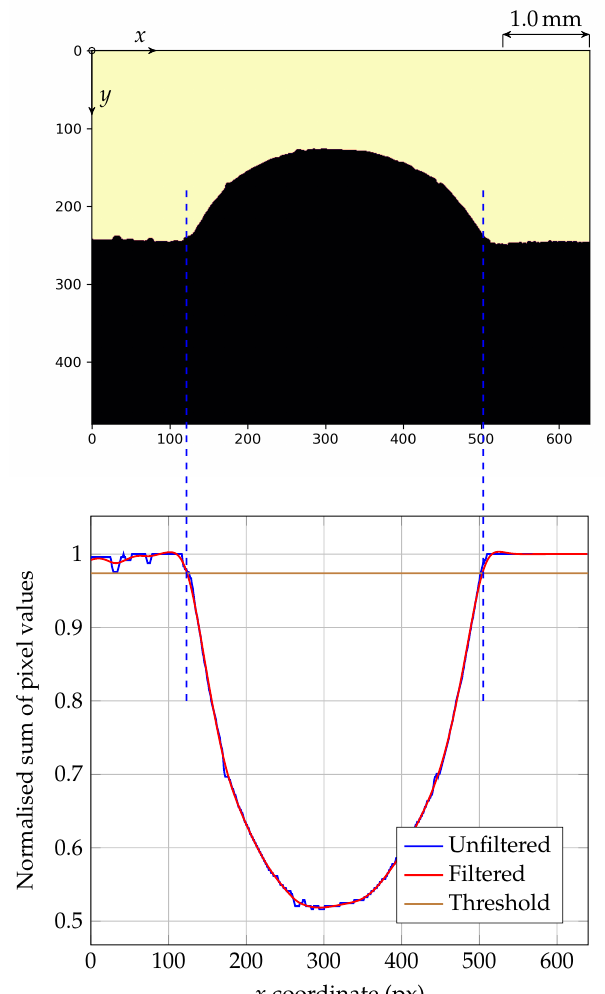
Figure 7. The detection of the bead’s limits through the interception of the normalised sum of pixel values with an established threshold (shown track equates to track 1).